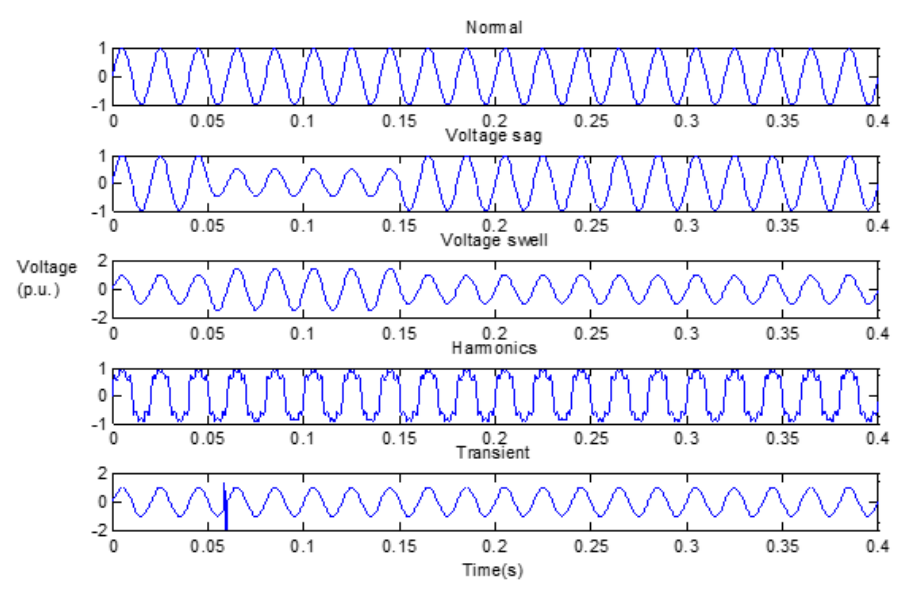
Figure 1. Different Power Quality Events.